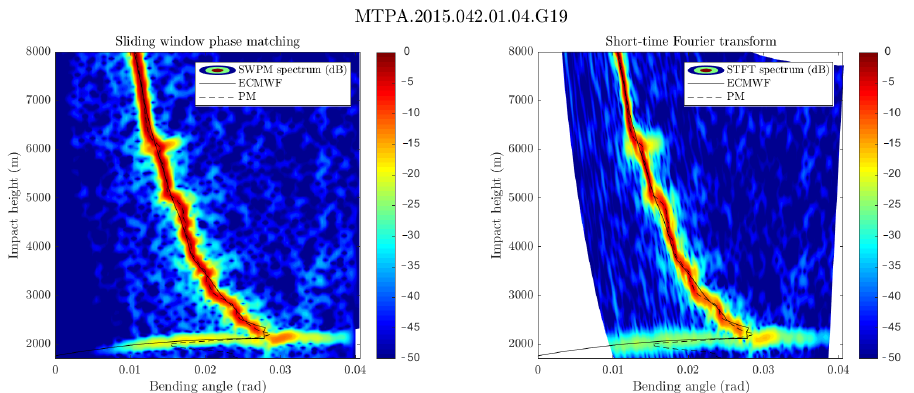
Figure 9. A MetOp-A occultation from UTC 0104 2015-02-10, 73.97 ◦ N, 143.19 ◦ W. Left shows SWPM, right shows STFT. ECMWF BA is shown in solid black, standard PM is shown in dashed black. The window length for STFT is 1.5 s.